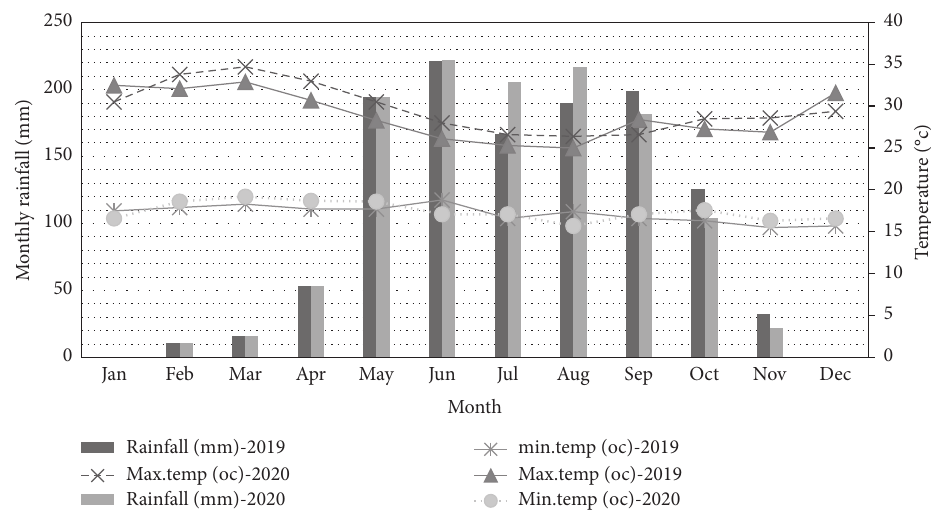
Figure 2: Average monthly rainfall and temperature distribution during 2019 and 2020 experimental years in